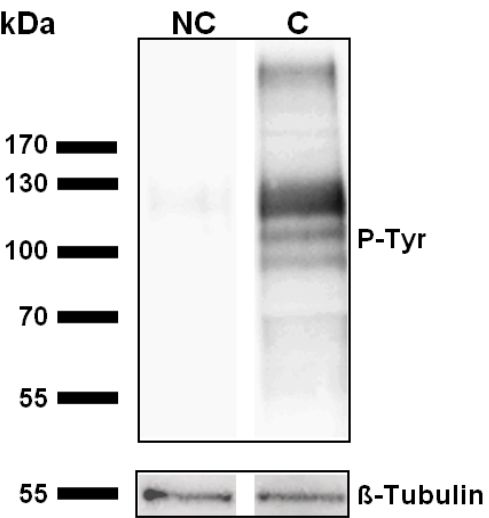
Figure 1. Assessment of sperm capacitation through protein tyrosine phosphorylation. Purified human spermatozoa were incubated (C) or not (NC) in a capacitating medium for 4 h. Proteins were then extracted and submitted to an immunoblot using anti-phosphotyrosine antibody (clone 4G10, Sigma-Aldrich). β -Tubulin was used as an internal reference. Representative results of N = 6 experiments.